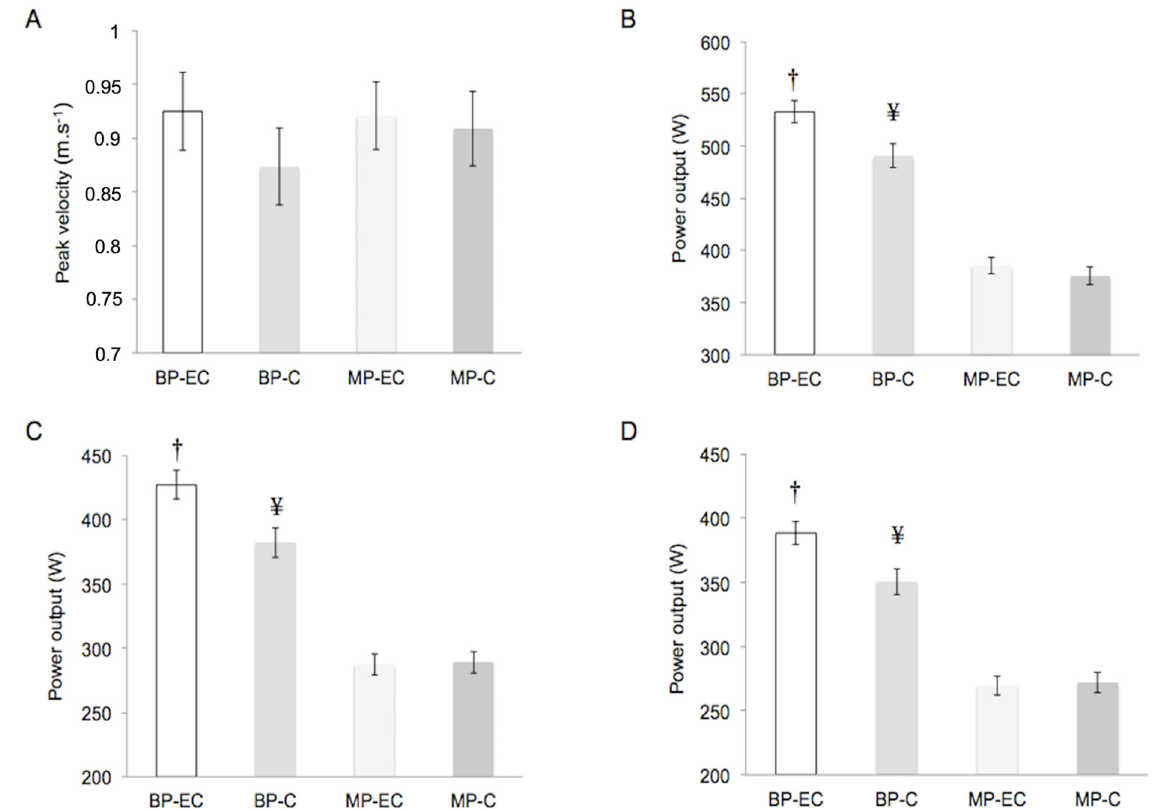
Figure 2. Movement velocity and power output data recorded in the military press (MP) and bench press (BP) tests. ( A ) Peak velocity. ( B ) Peak power output up to peak velocity. ( C ) Mean power output up to peak velocity. ( D ) Mean power output up to braking phase. Abbreviations: C = concentric; EC = eccentric–concentric. † Significantly different to BP-C, MP-EC, MP-C ( p ≤ 0.01). ¥ Significantly different to MP-EC, MP-C ( p < 0.001). Data are presented as mean of all loads lifted during the isoinertial strength test.